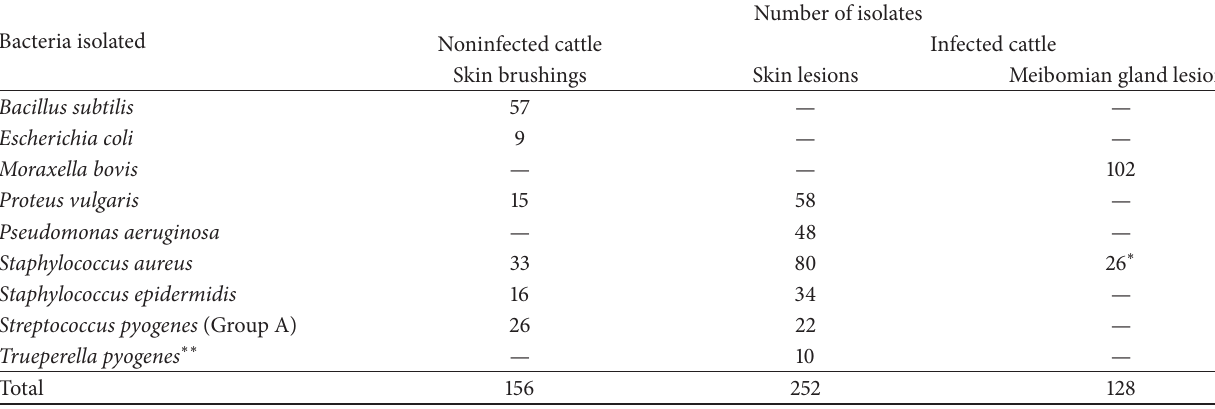
Table 2: Number of bacterial isolates from skin brushings from noninfected cattle and number of isolates from skin and meibomian gland lesions of demodectic mange.